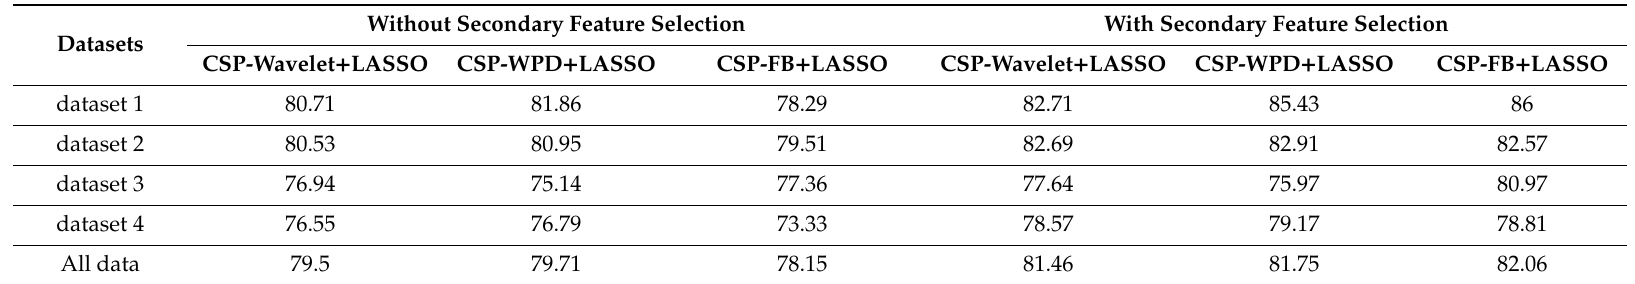
Table 6. The e ff ect of secondary feature selection on average classification accuracy of various datasets (the LASSO method).